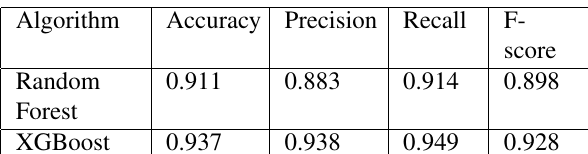
Figure 4. Gradient Boosting Visualization [8] Table 2. Summary of test results